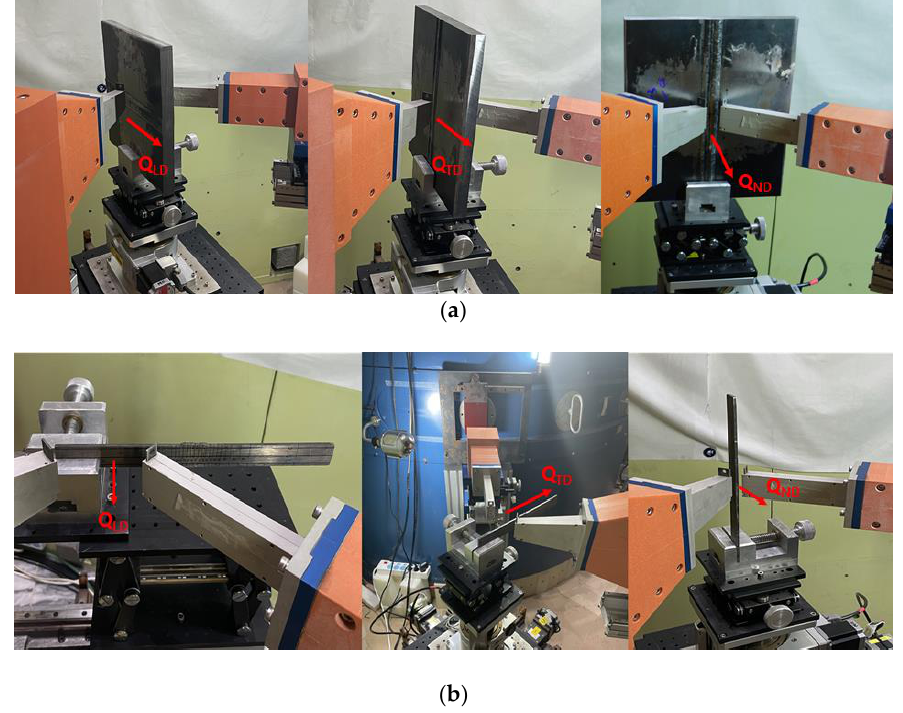
Figure 7. Neutron diffraction to measure welding residual stress. ( a ) Neutron diffraction process of bulk specimens; ( b ) neutron diffraction process of stress-free specimens.